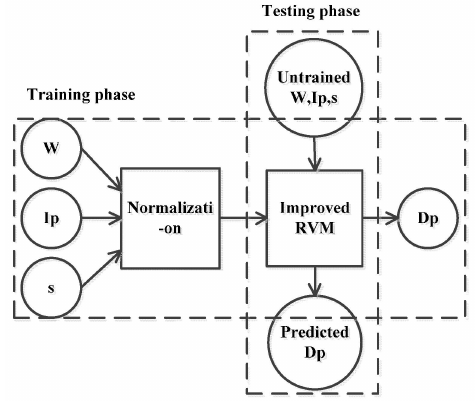
Figure 10. Schematic overview of the proposed RVM